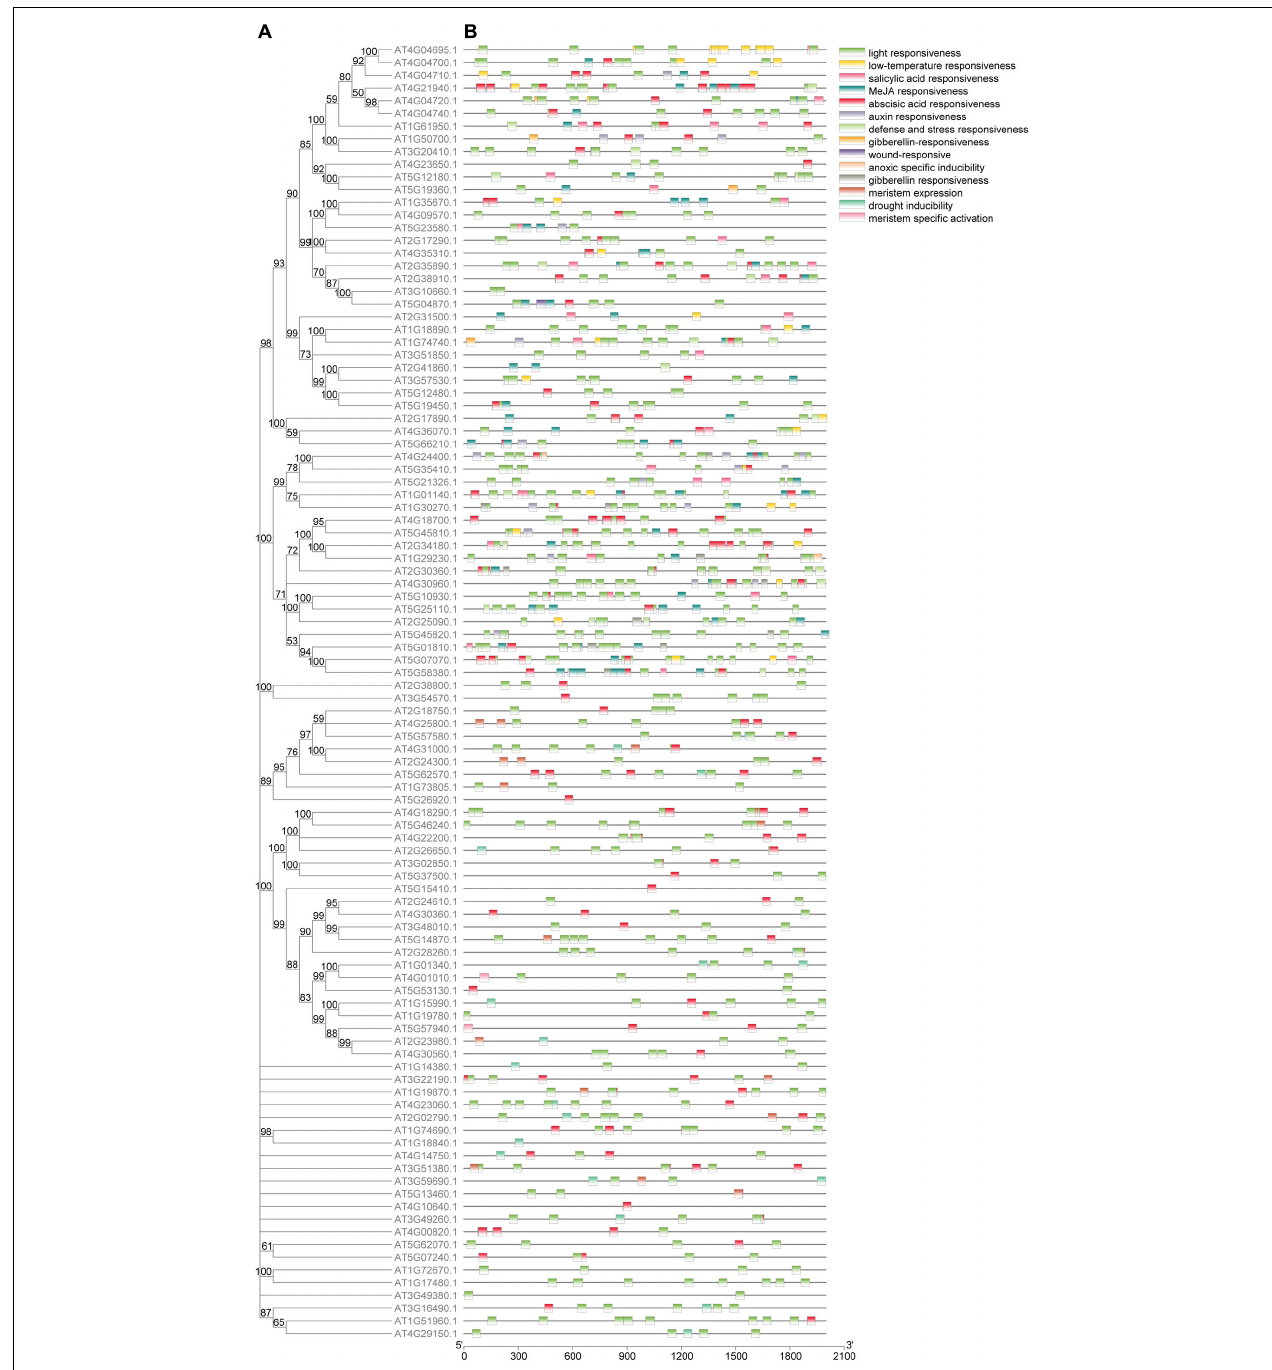
FIGURE 3 | Phylogenetic relationship and cis -element of the 102 genes in calcium-related gene families . (A) Phylogenetic tree constructed based on the full-length protein sequences with MEGA-X software. Each branch was supported by a bootstrap value. (B) The cis -element identified by PlantCARE based on the sequence of 2,000 bp upstream of the start codon of the 102 genes in calcium-related gene